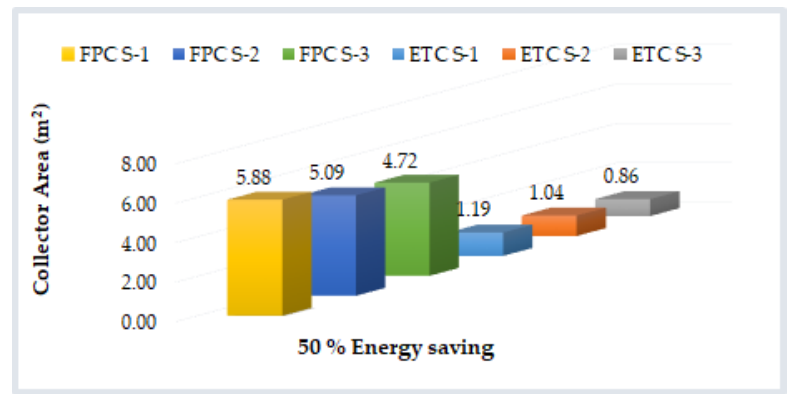
Figure 16. Collector area per kW of cooling